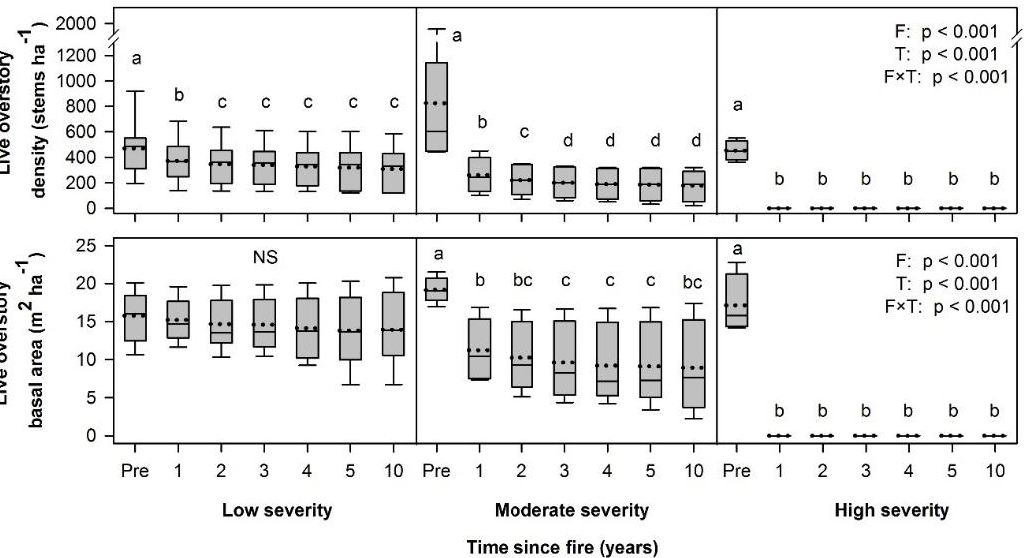
Figure 2. Live overstory (trees > 1.4 m tall) density ( top ) and basal area ( bottom ) with respect to fire severity and time since fire. Boxes represent 25th, 50th, and 75th percentiles, whiskers represent 10th and 90th percentiles, and dotted lines represent means. The p -values are model results for the effects of fire severity (F), time since fire (T), and their interaction (F×T). Within fire severity classes, letters separate means though time; NS indicates that means did not differ.